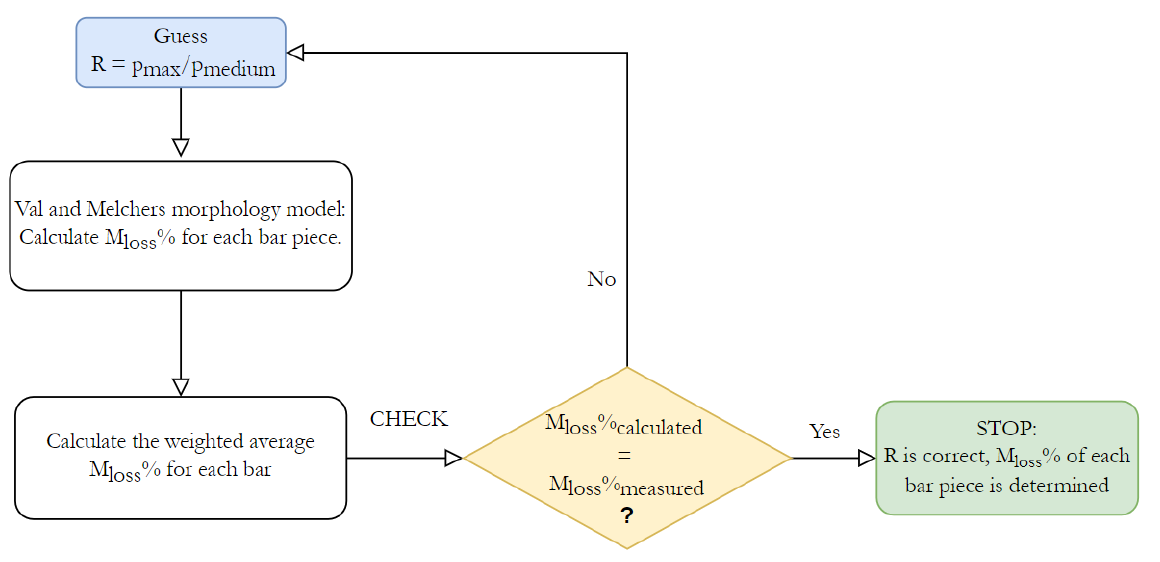
Figure 8. Flow chart of the inverse method for morphology-based mass loss evaluation. Table 5. Pitting factor and lost mass assumed for strategy 4, column